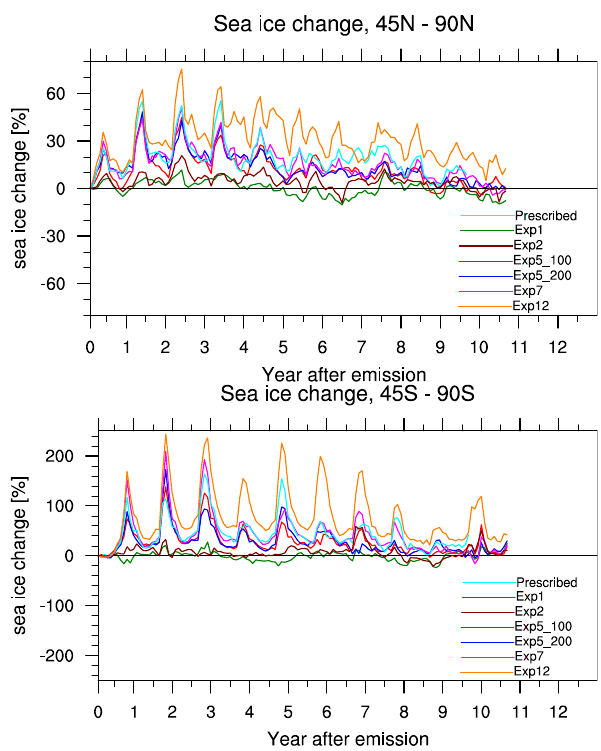
Fig. 8. Changes in total sea ice coverage [ % ] for the latitude band 45 to 90 ◦ N (upper panel), and 45 to 90 ◦ S (lower panel) as function of time.